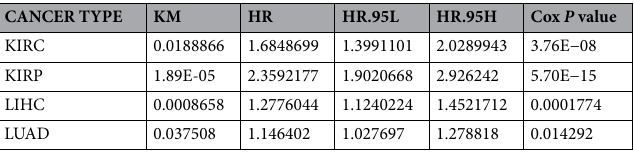
Table 1. TOP2A associated with poor OS by the Kaplan–Meier survival curve and Log-rank